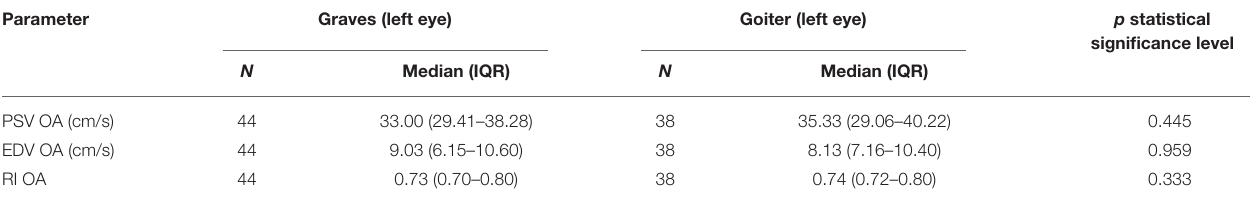
TABLE 5 | Comparison of blood flow parameters (PSV, EDV, RI) in ophthalmic artery in Graves’ disease and toxic nodular goiter patients. Parameter Graves (left